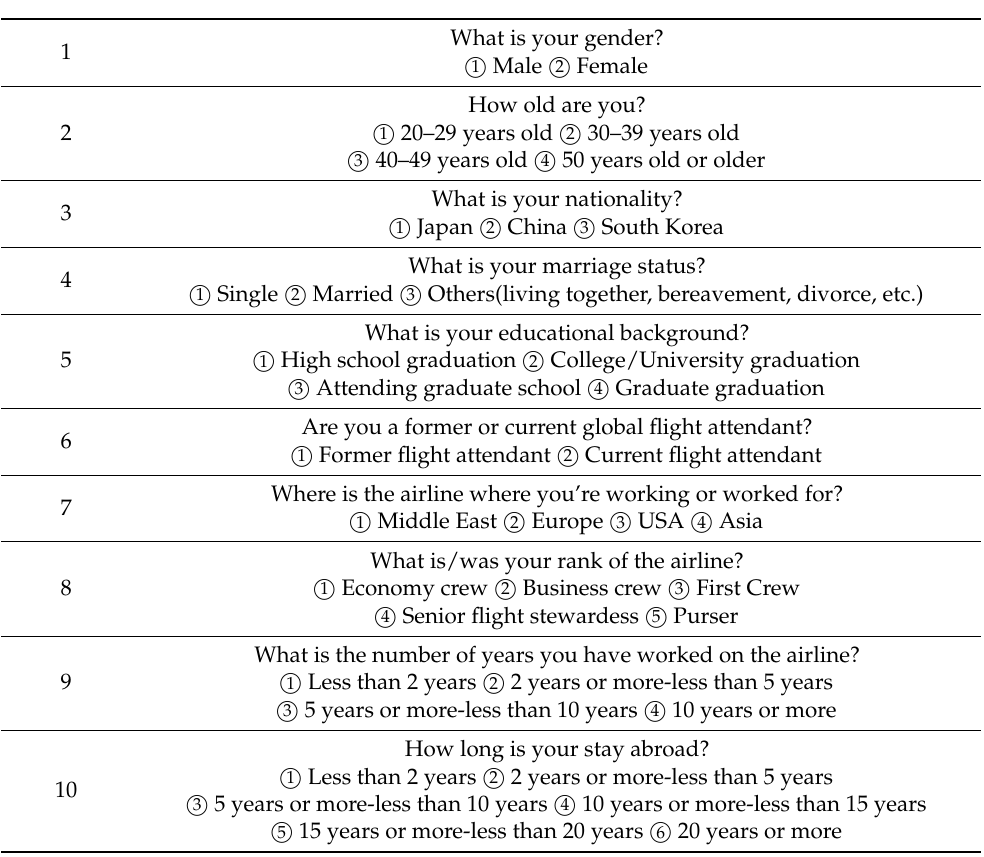
Table A2. The following questions are about ‘demographic